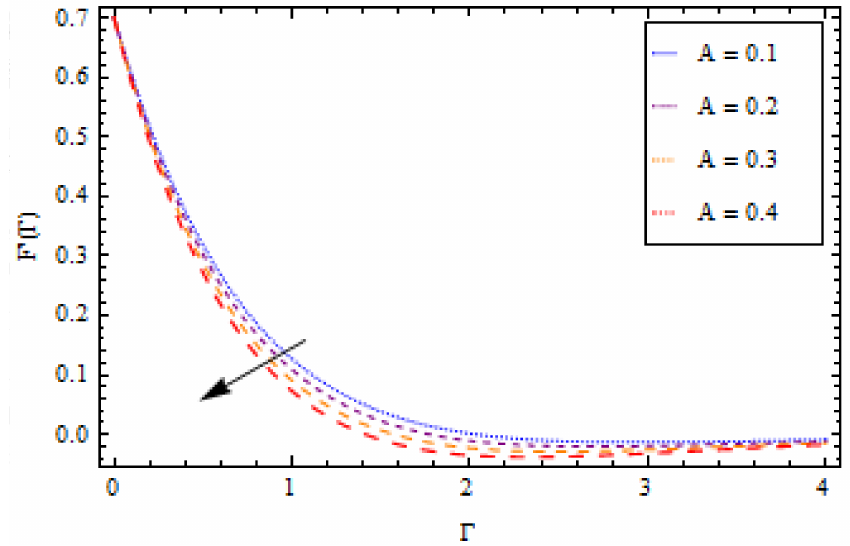
Figure 4. Impact of A on velocity profile F (cid:48) ( Γ ) when Pr = 0.5, K = 0.5, Rd = 0.5, λ = 0.5, κ = 0.5, γ = 0.5, Sin τ =